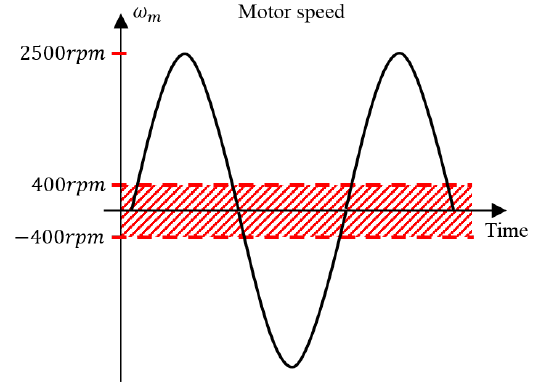
Figure 11: Typical winch speed situation for a winch doing heave